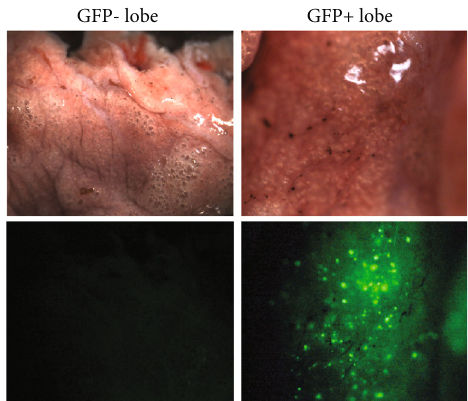
Figure 6: Bronchoscopic delivery of hDASCs into the macaque